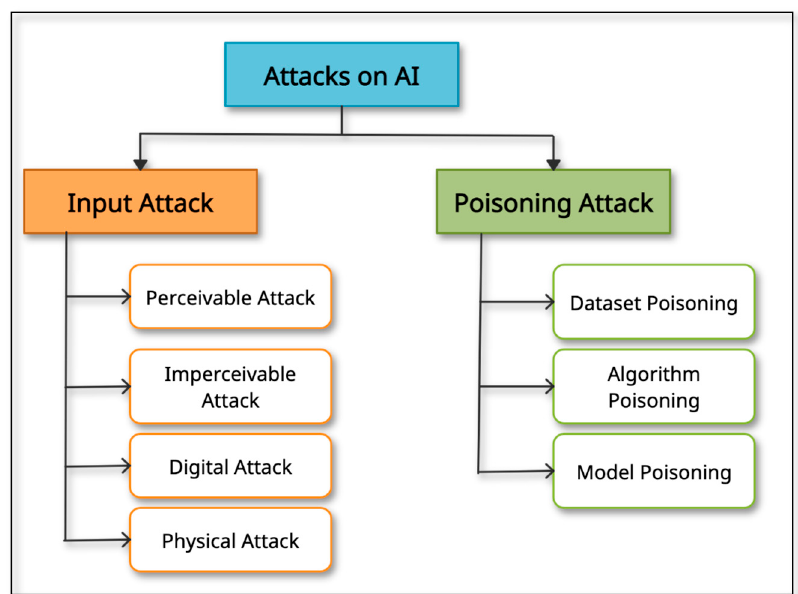
Figure 1. Categories of Attacks on AI.